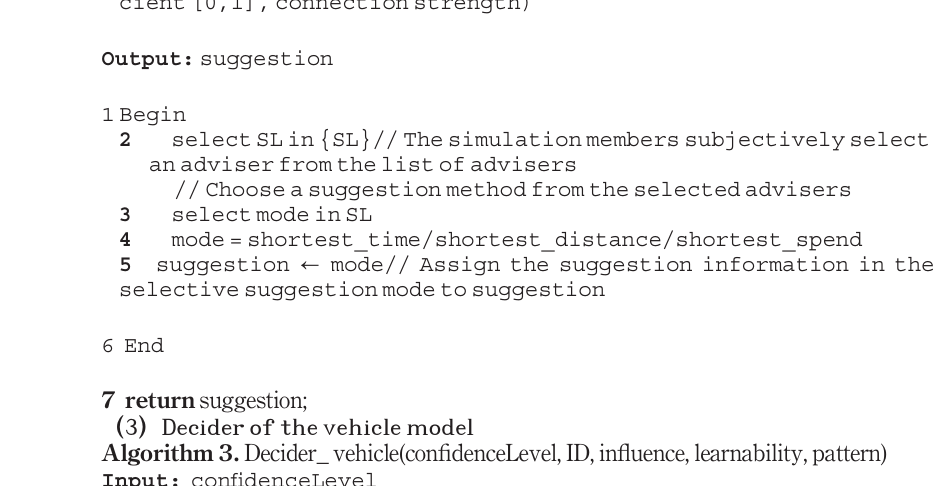
Algorithm 2. Affecter_vehicle(ID, {SL})